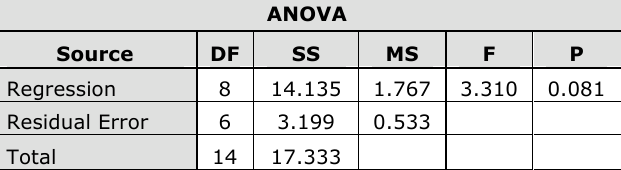
Table 3. “Summary of Coefficient Analysis”